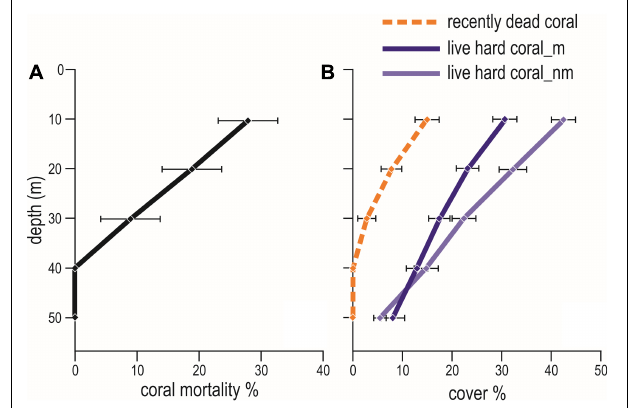
FIGURE 7 | Mean ( ± standard error) values of: (A) coral mortality down a depth profile (from 10 m to 50 m); and (B) percent cover of live hard coral in years with coral mortality (i.e., 1999, 2007, 2016, 2017, and 2018) (live coral_m, dark violet solid line) and in years without coral mortality (i.e., 1997, 1998, 2012, 2013, 2015, and 2019) (live coral_nm, violet solid line), and of recently dead coral (orange dashed line) in the Maldives.